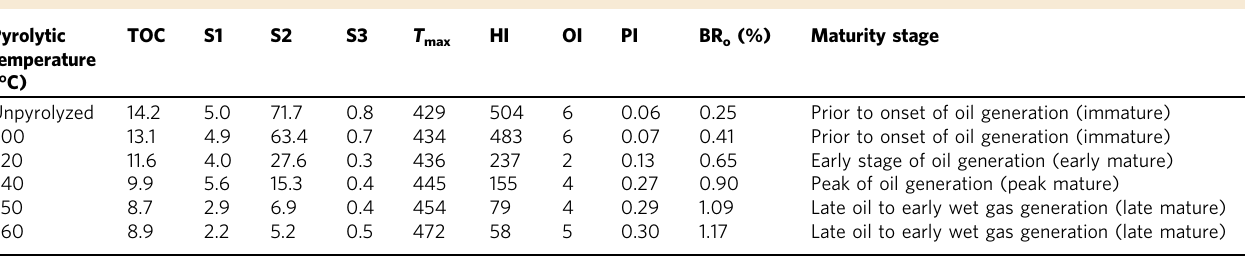
Table 1 Organic geochemistry of the New Albany Shale sample and its hydrous pyrolysis derivative Pyrolytic